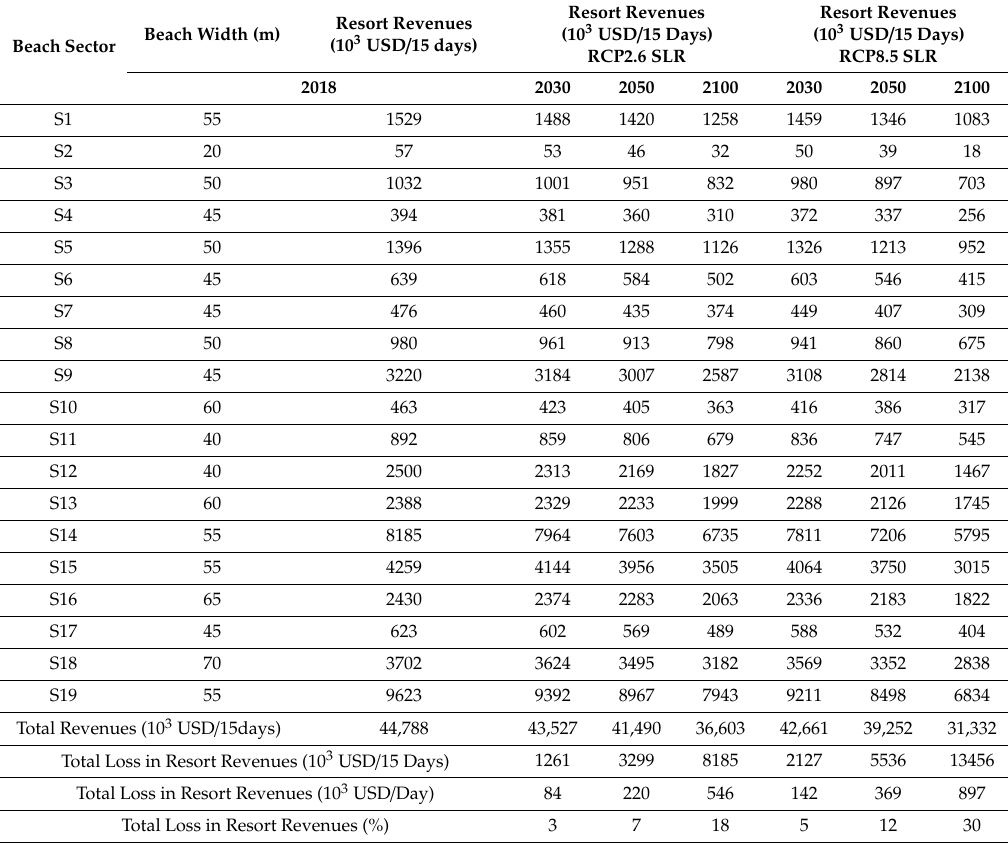
Table 3. Beach width and resort revenues along Sahl Hasheesh and Makadi Bay due to SLR (coastal slope =